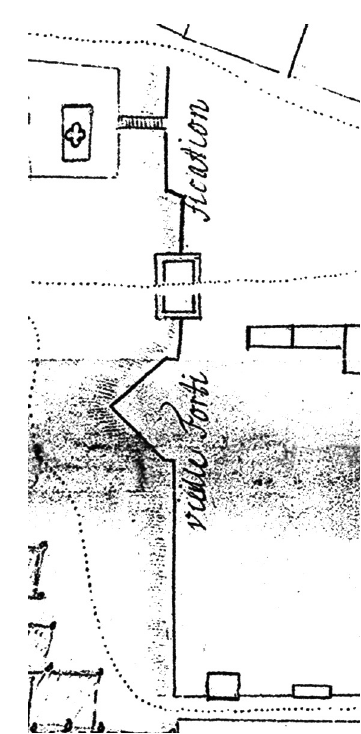
Fig. 4. A part of the map showing the third line of fortifications